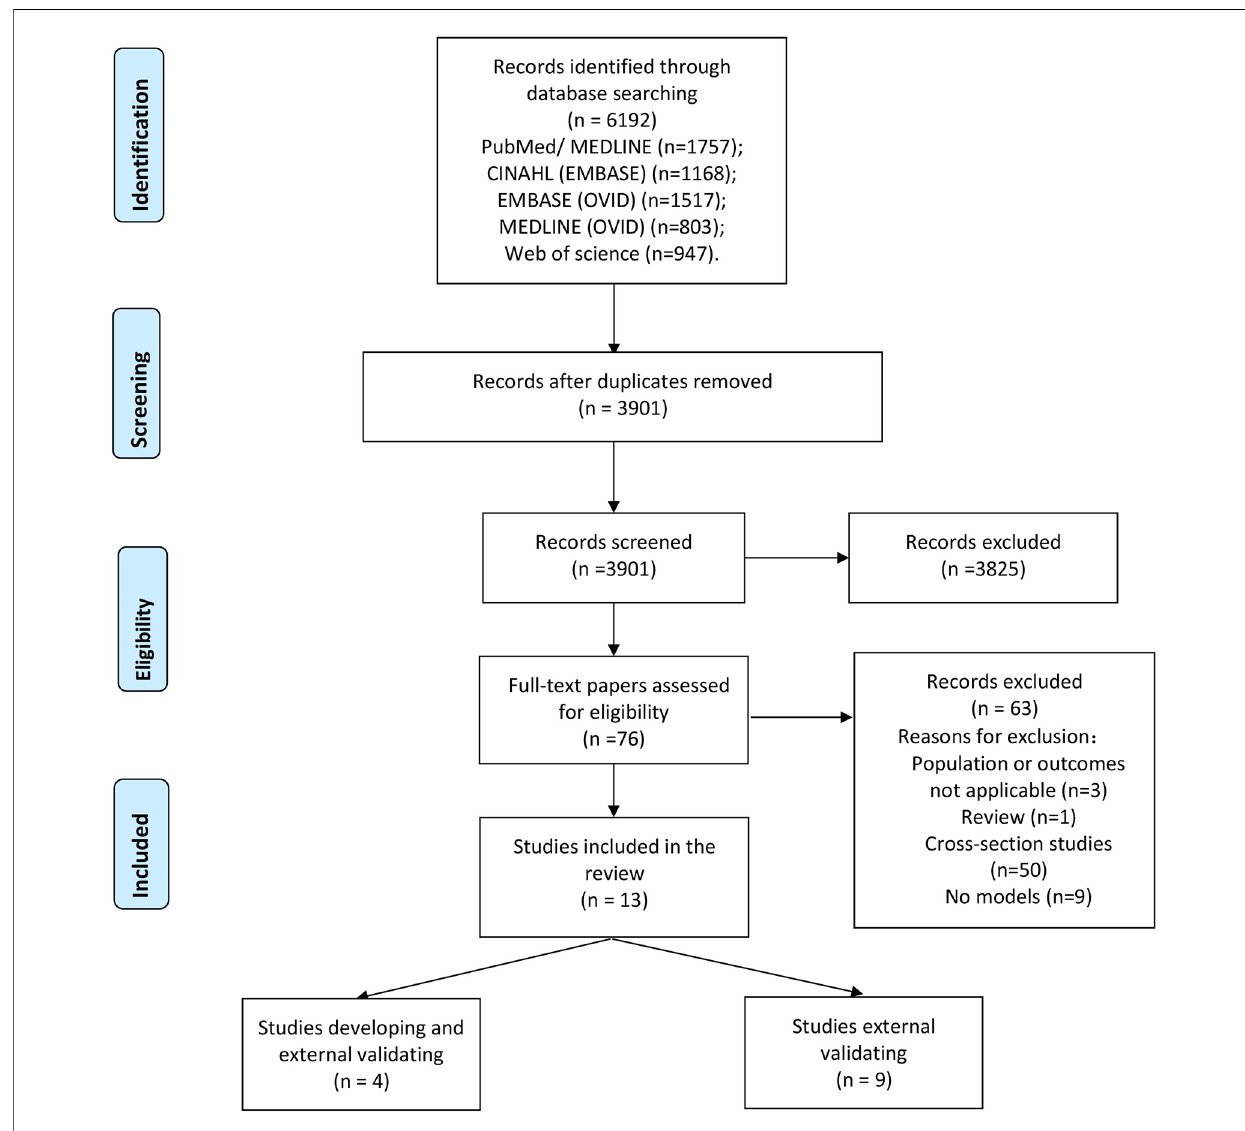
FIGURE 1 Flow diagram of the selection